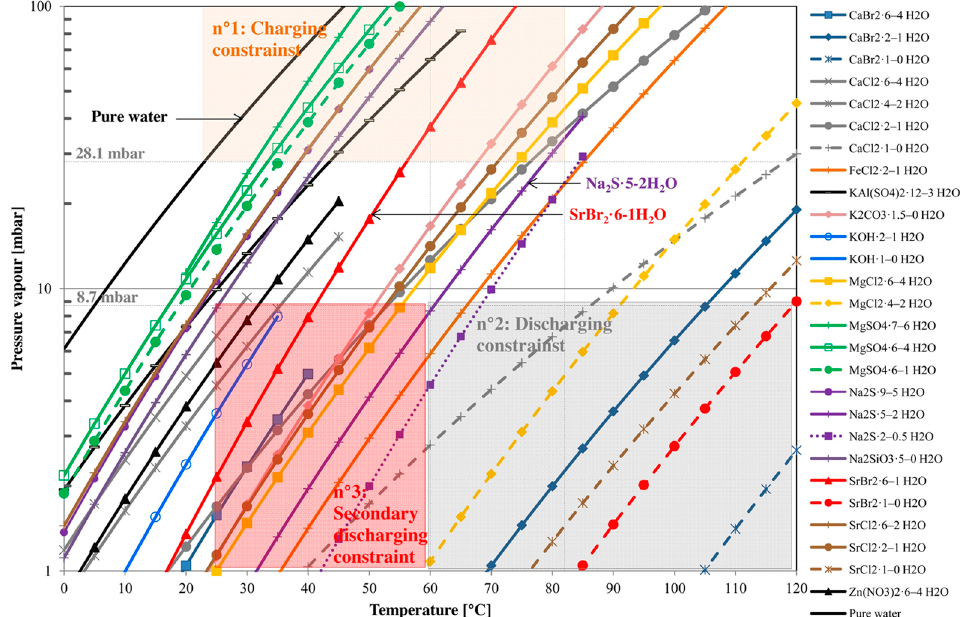
Figure 8. Equilibrium curves for various thermochemical materials and thermodynamic